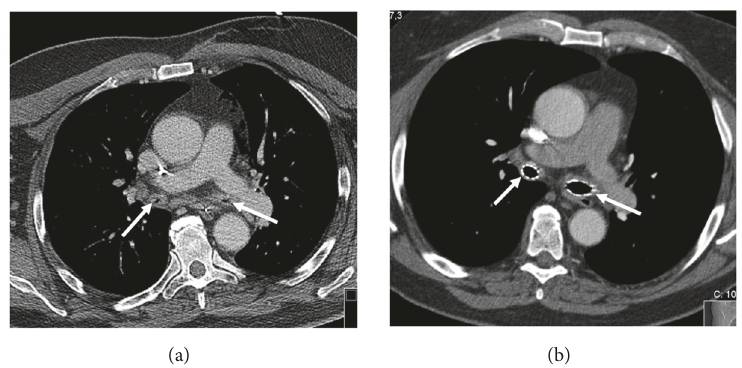
Figure 1: CT imaging before (a) and after (b) stenting. Arrows pointing at main